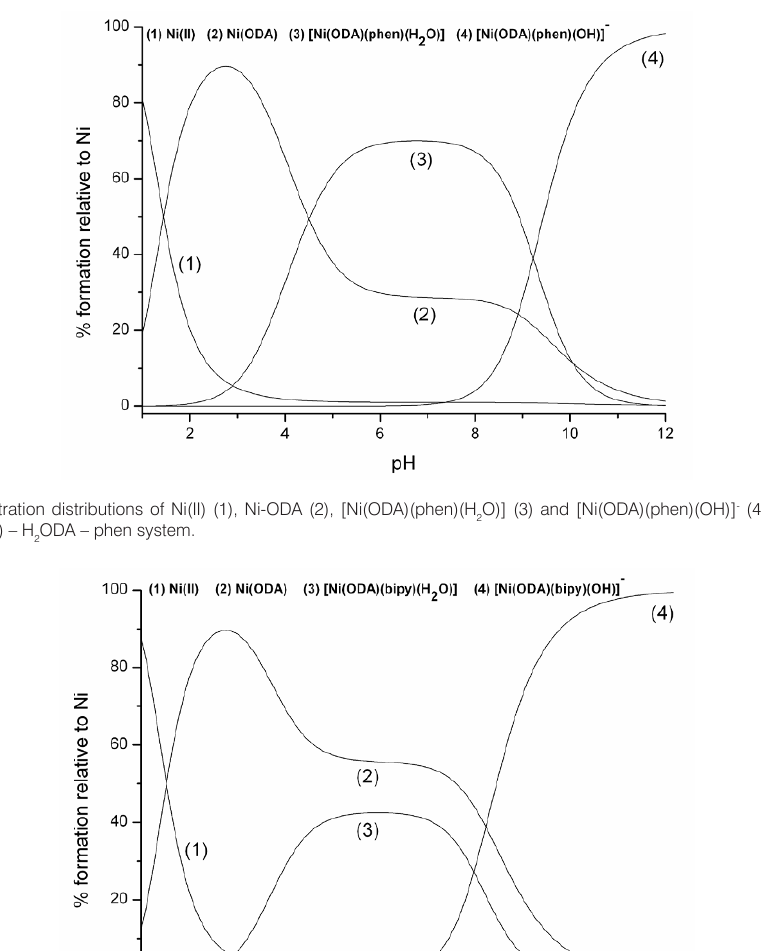
O)] (3) and [Ni(ODA)(bipy)(OH)] - (4) as a function of pH in 2